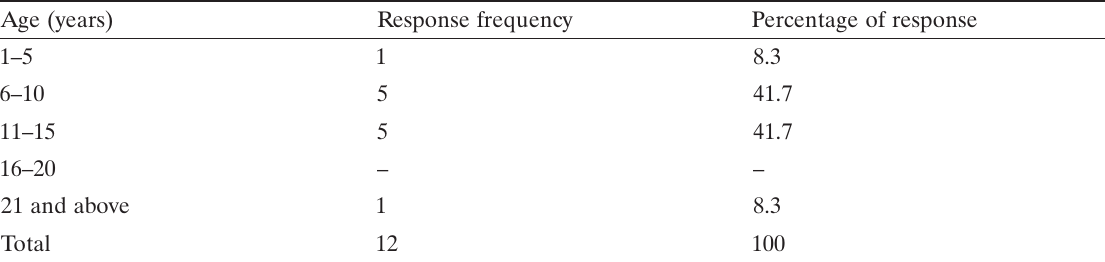
Source: Field data analysis,